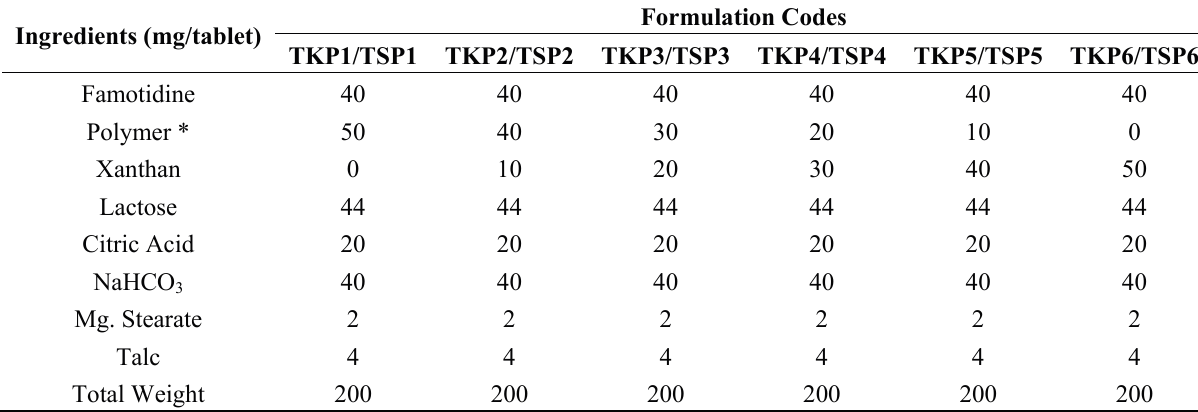
Table 4. Formulation composition of famotidine matrix tablets using different concentrations of TKP and